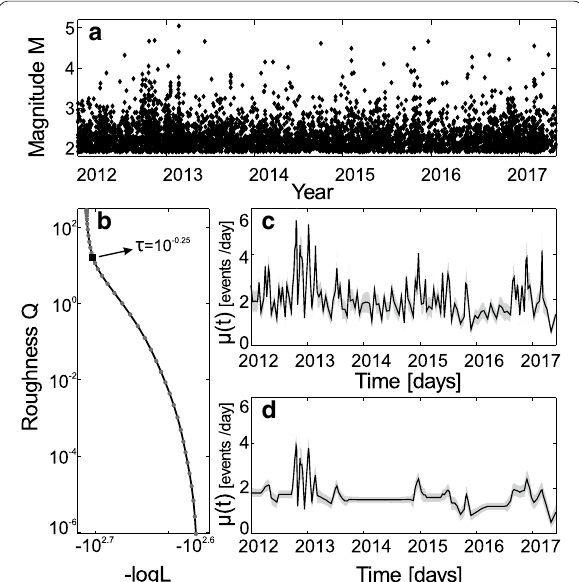
Fig. 7 Results for the GeoNet catalog analyzed using non-stationary ETAS model. The magnitudes of earthquakes in the catalog examined in the study are plotted versus time in ( a ). The computed L-curve along with the point corresponding to the chosen smoothness parameter is shown in ( b ). The background rate functions estimated using the models NS_L_MP and NS_Adapt are presented in ( c , d ) respectively, along with the error bounds computed using Hessian matrix of (cid:31) at the